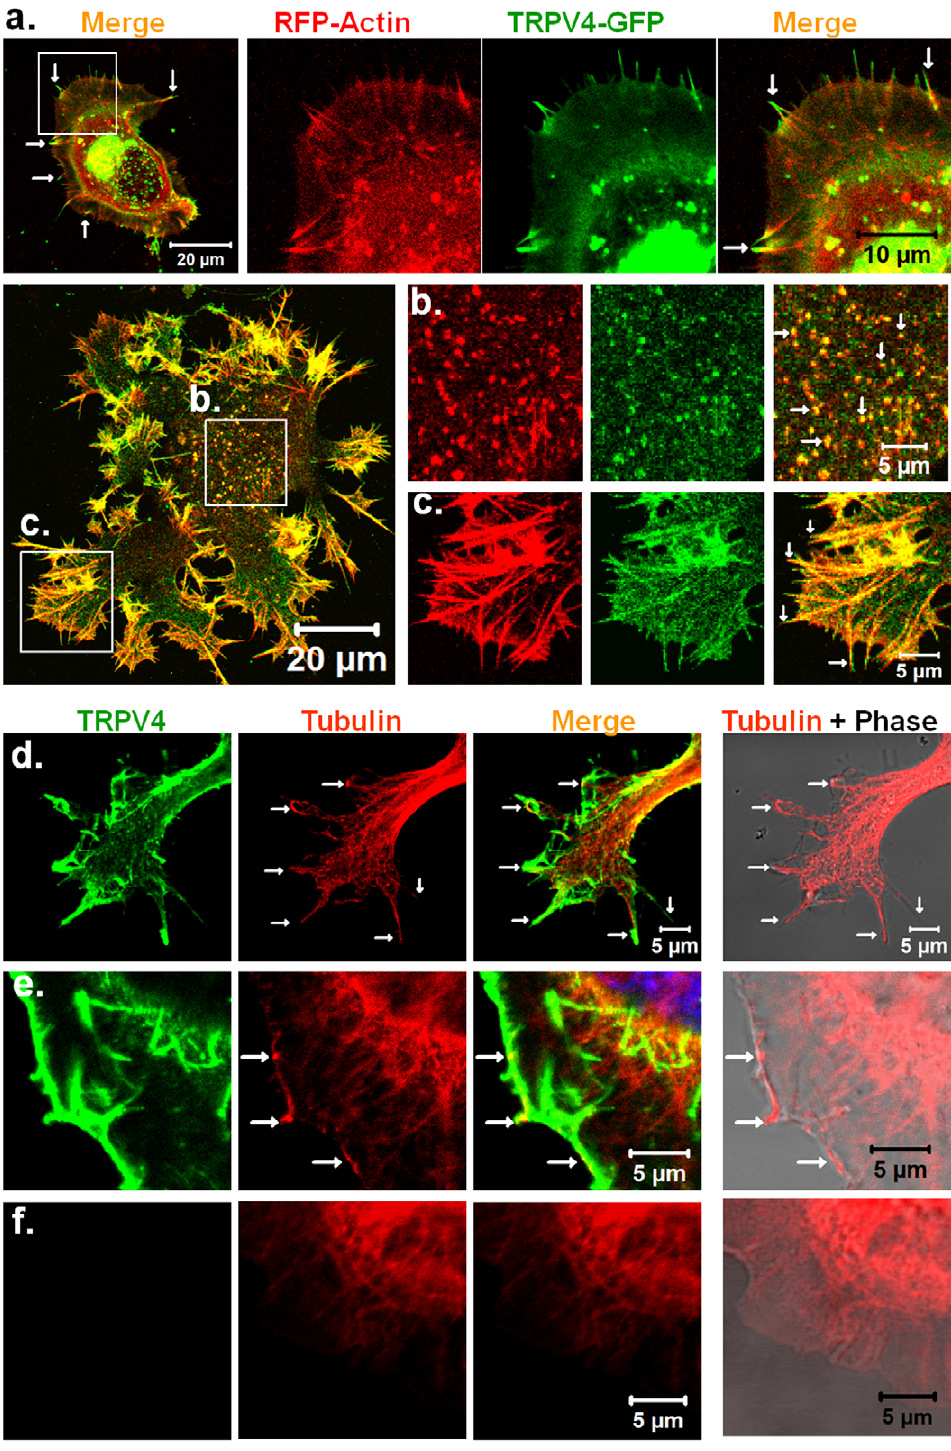
Figure 3. TRPV4 co-localizes with actin and microtubule cytoskeleton. a–c. Shown are the live-cell confocal images of F11 cells expressing TRV4-GFP (green) and RFP-actin (red). Presences of TRPV4-GFP specifically in actin-enriched structures are shown. a. Enlarged view of lamellipodia and at the tip of the actin filaments are shown. b–c. Enlarged view of focal adhesion point-like structures (b) and cell cortex with actin ribs (c) are shown. Arrows indicate the localization of TRPV4-GFP at filopodial tips. d–f. TRPV4 co-localizes with microtubule cytoskeleton. Shown are the confocal images of F11 cells immunostained for TRPV4 (green) and tyrosinated tubulin (red). Arrows indicate presence and acumulation of microtubules in thin filopodial structures (d, upper panel) and thin lamellipodial structures (e, middle panel). The status of the microtubules in the non-transfected cells are shown in below (f, lower panel).